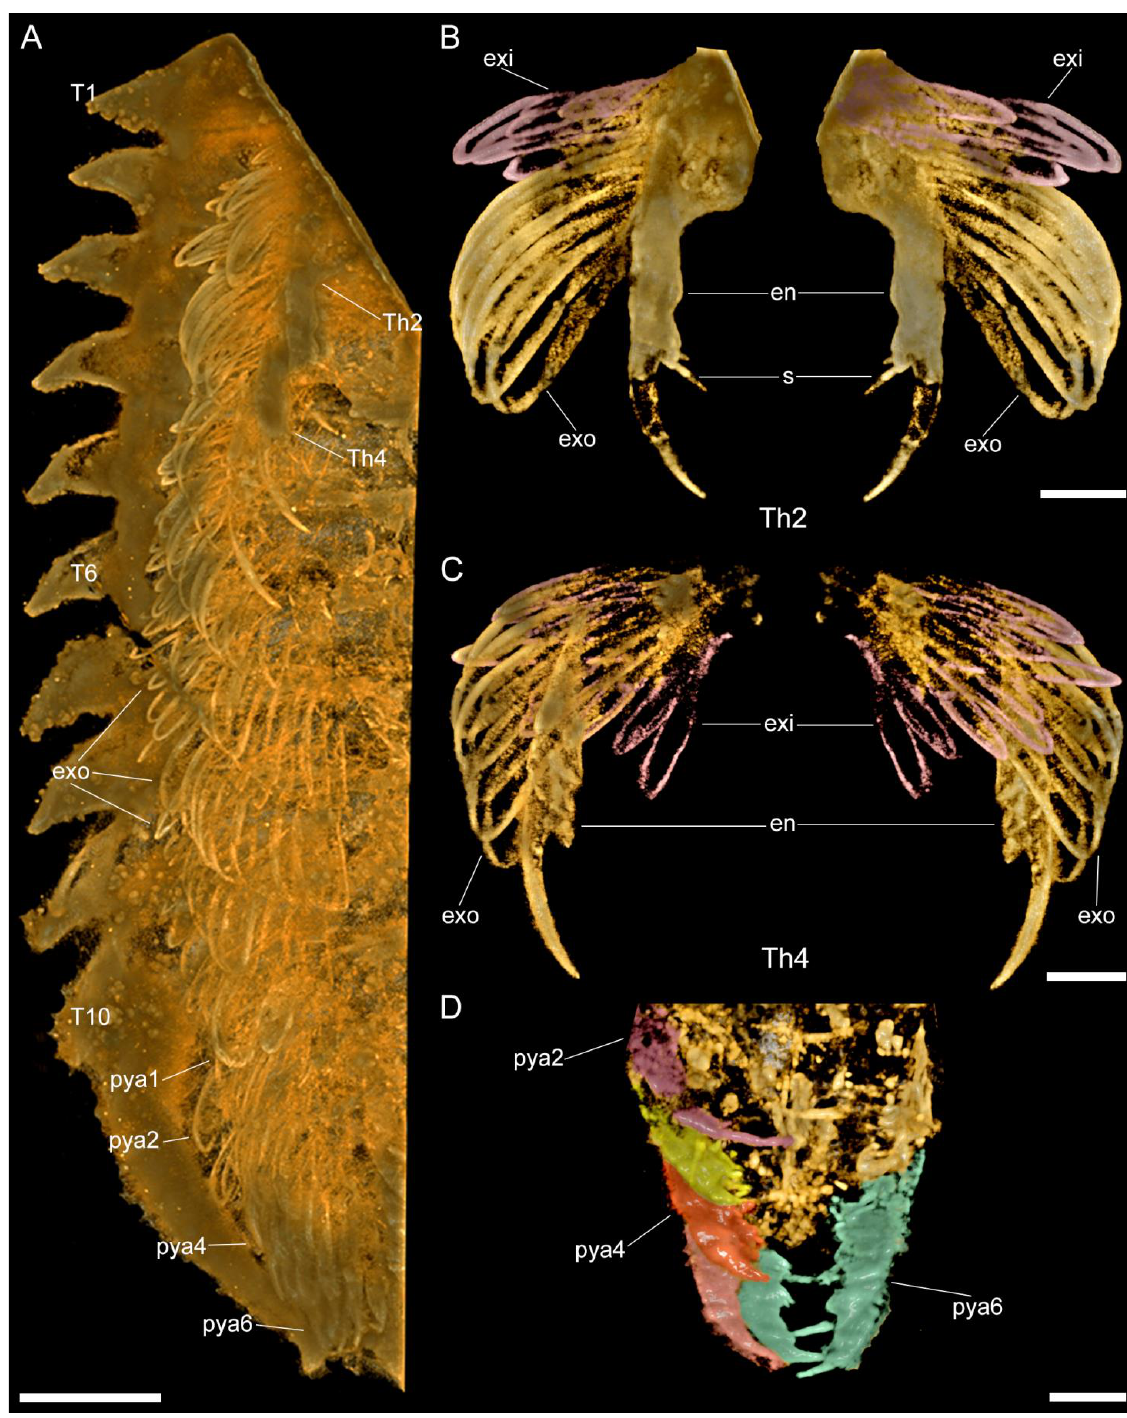
Figure 3. Images rendered from 3D tomographic models of Retifacies abnormalis (YKLP 11426, Figure A1D) showing details of thoracic and pygidial appendages. ( A ) Ventral view of appendages from the right side of the animal. ( B , C ) Ventral and dorsal views of second (Th2) and fourth (Th4) right thoracic appendages with exites (false-coloured in purple) proximally attached to their respective protopodites. ( D ) Ventral view of endopodites of all preserved pygidial appendages, with pygidial shield and exopodites digitally removed for clarity. Each endopodite false-coloured differently. Other abbreviations: en — endopodite; exi — exite; pyan — nth pygidial appendage. Scale bars: 5 mm in ( A ) and 2 mm in ( B – D ).